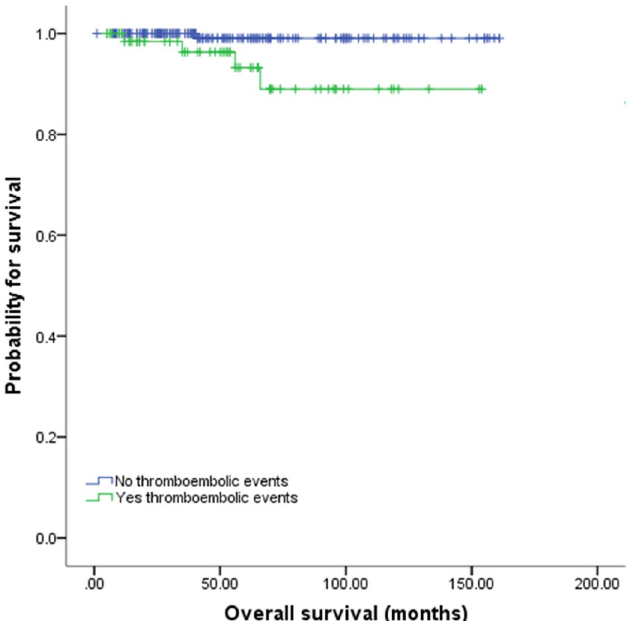
Figure 3. Overall survival according to thromboembolic events.